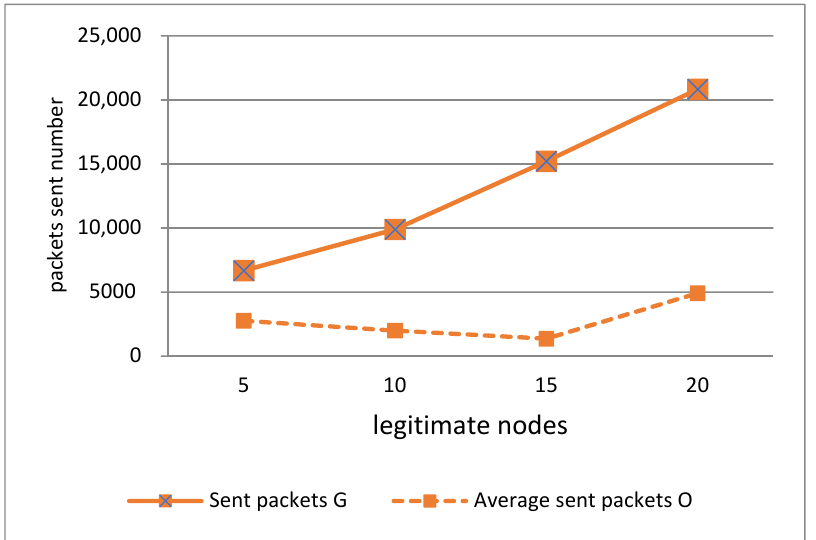
Figure 3. Packets sent by legitimate and greedy nodes.